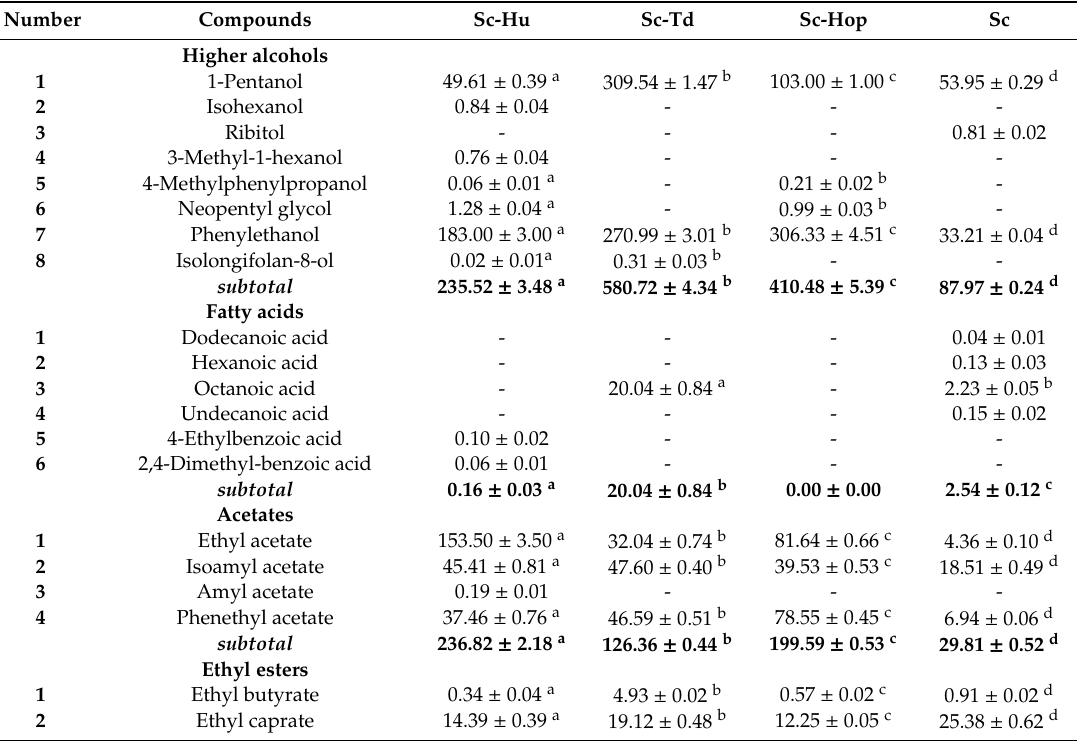
Table 2. Volatile aroma compounds in citrus wines (Means ± SD, mg /